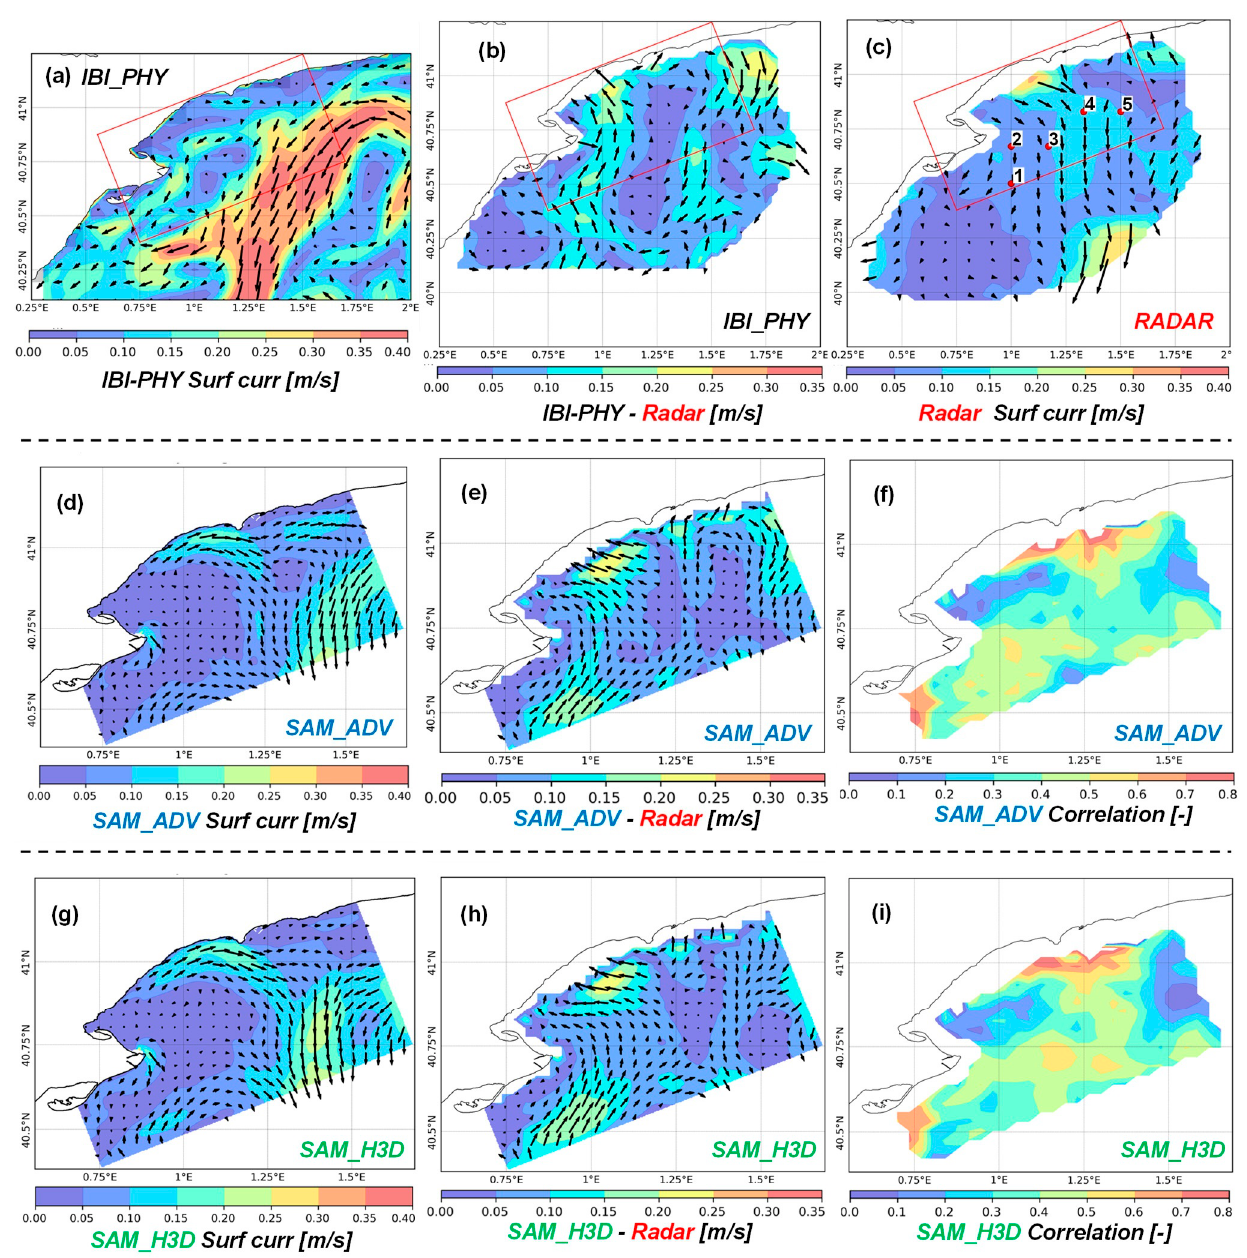
Figure 6. HF Radar vs. model solutions (SAM_H3D and SAM_ADV experiments, together with the Copernicus IBI parent solution) at Tarragona during March 2020. Monthly-averaged surface current field modelled and observed, depicted at subpanels ( a ) (IBI_PHY)-( d ) (SAM_ADV)-( g ) (SAM_H3D), joint with ( c ) (HF Radar), respectively. However, the error metrics subpanels ( b , e , f , h , i ) are computed from hourly-averaged fields. Model-observation monthly biases for IBI_PHY, SAM_ADV and SAM_H3D are depicted in the central column (subpanels b , e , h ); SAM_ADV and SAM_H3D model correlation fields with HF Radar observations are shown in subpanels ( f , i ). Units in m/s. The red rectangle in subpanels ( a – c ) the SAMOA coastal domain. Red dots at subpanel ( c ) represent locations where time series metrics are computed (summarized in Table 5).